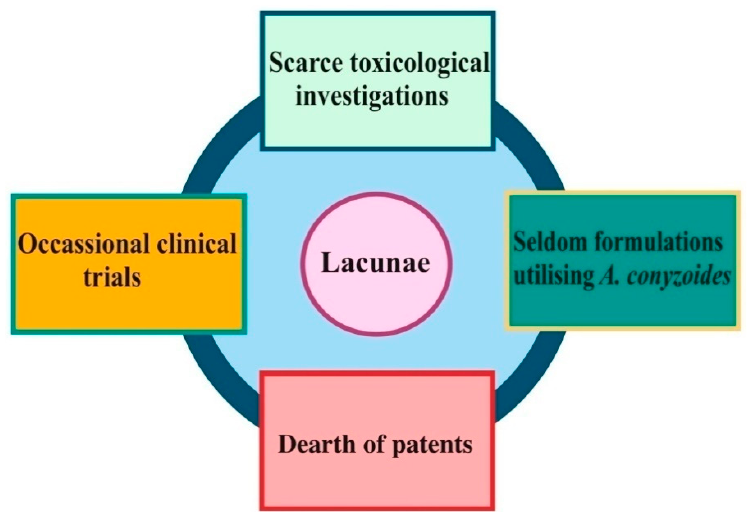
Figure 5. Lacunae observed in the clinical establishment of Ageratum conyzoides.